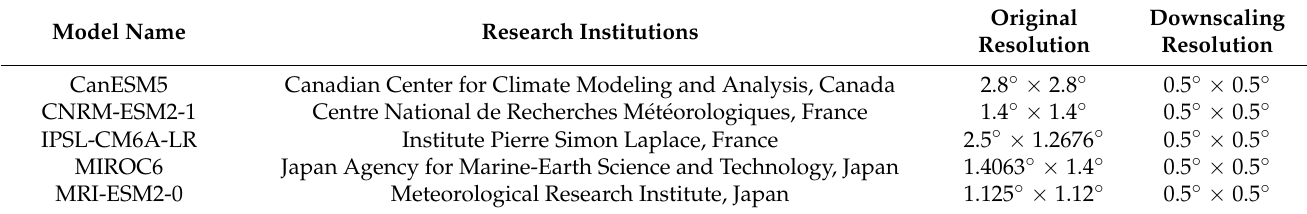
Table 1. General information of 5 GCMs in CMIP6.